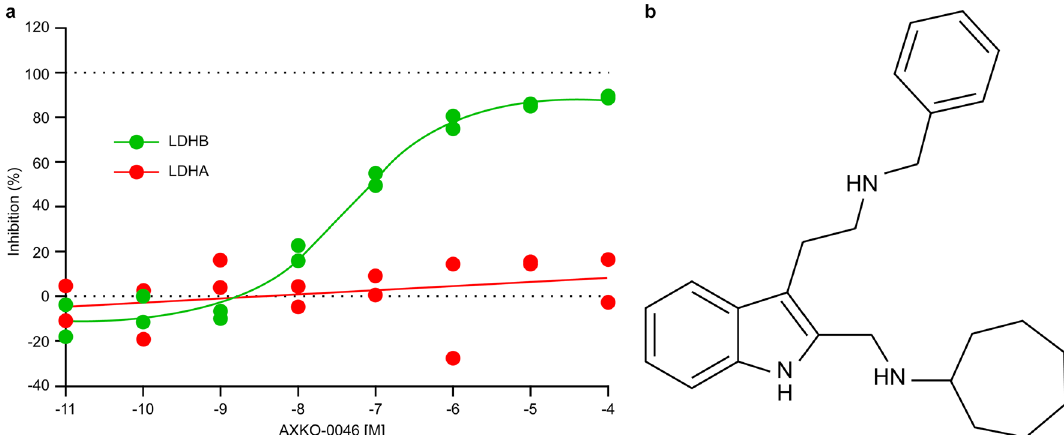
Figure 2. Concentration response curve and the structure of AXKO-0046. ( a) Concentration response curves and EC 50 values of AXKO-0046. AXKO-0046 selectively inhibited LDHB (green circles) but did not inhibit LDHA (red circles). The EC 50 for LDHB was 42 nM. The curves were fitted to the standard four-parameter logistic equation. ( b) Structure of